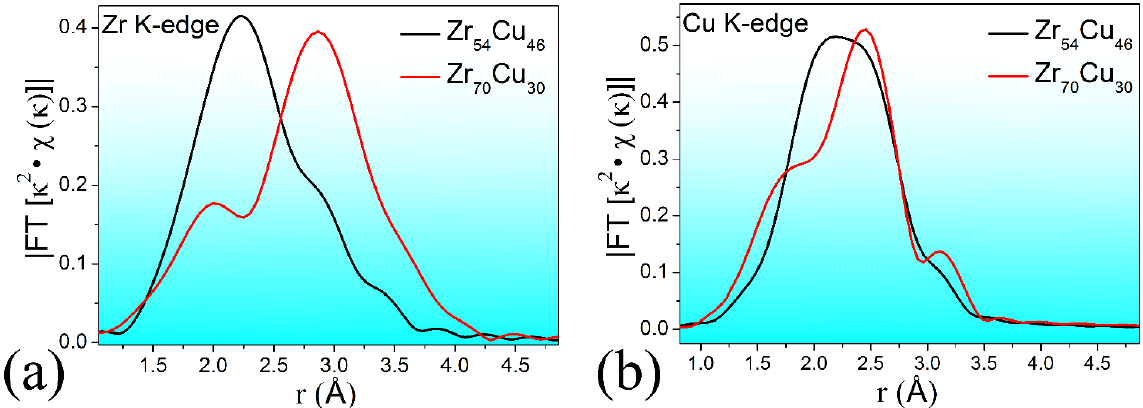
Figure 3. The radial distribution functions (RDFs) obtained by reverse Fourier transforming the EXAFS signal into real space, including: ( a ) Zr K-edge and ( b ) Cu